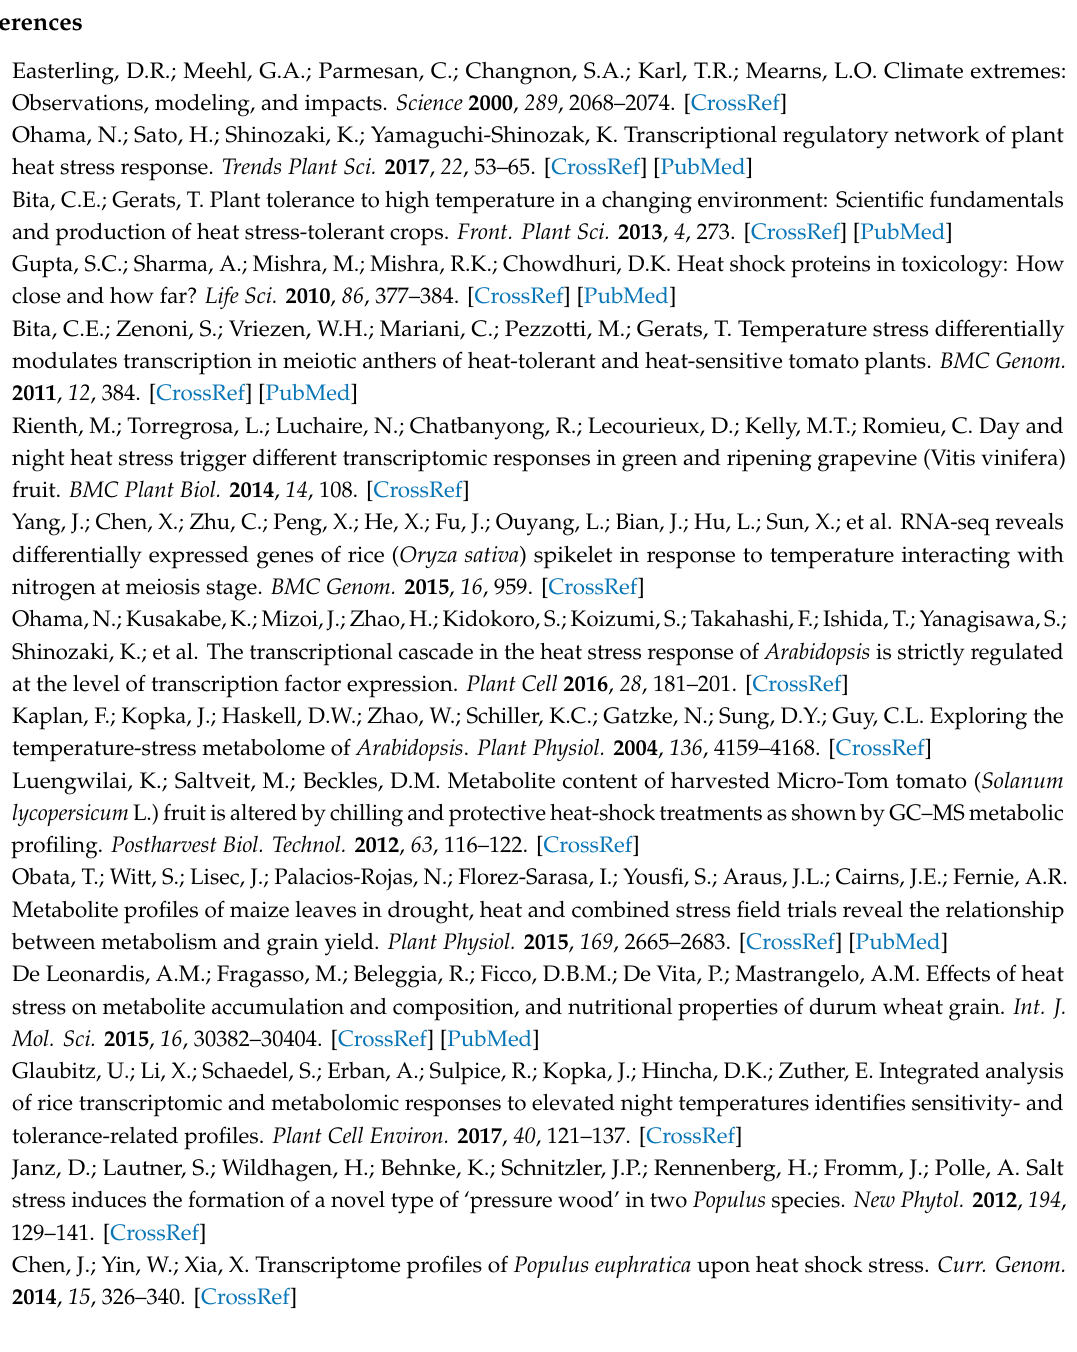
(b) Top 20 enriched KEGG pathways between heat treatments and the control (arrows, significant enrichments associated with heat stress), Table S1: A list of the quality of sequencing data, Table S2: Detailed information of some important DEGs under heat stress for 5 hours, Table S3: Detailed information of DEGs (more than 1.5-log2 fold change) under heat stress, Table S4: DEGs encoding transcription factor families, Table S5: Primers used for